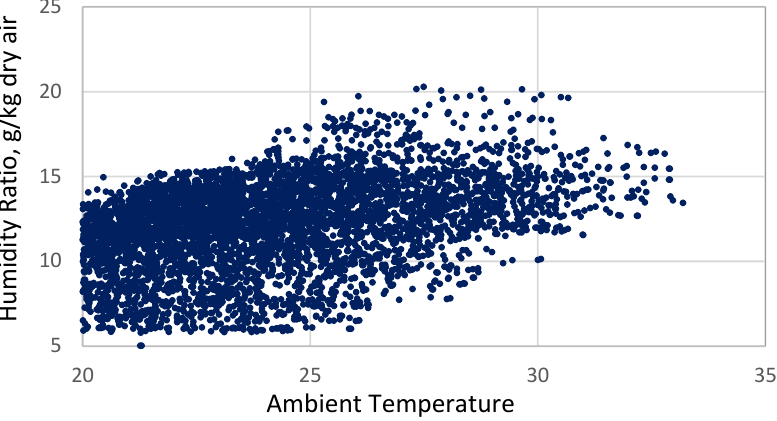
Figure 6. Air-humidity ratio vs. ambient temperature for cooling months.